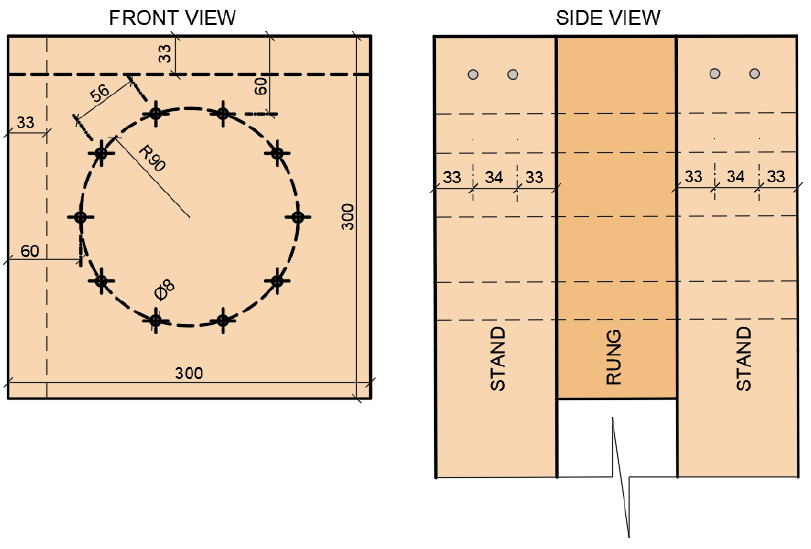
Figure 8. Deployment of fasteners.